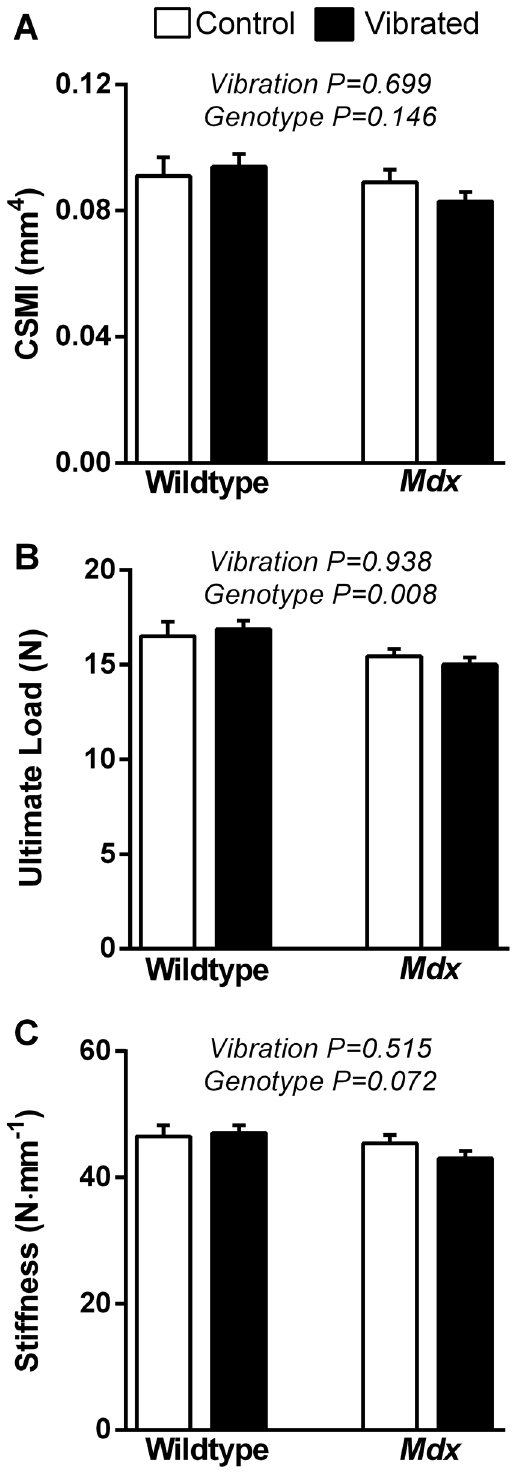
Figure 5. Eight weeks of vibration training did not impact tibial cortical bone. Vibration training for 8 weeks did not influence the following tibial cortical bone properties: A) cross-sectional moment of inertia, B) ultimate load, or C) stiffness. Mdx mice had lower values for ultimate load and trends for lower stiffness compared to wildtype mice. Data are means 6 SE. P-values associated with the main effects of two- way ANOVAs are indicated above each set of bars. Interactions between vibration and genotype P $